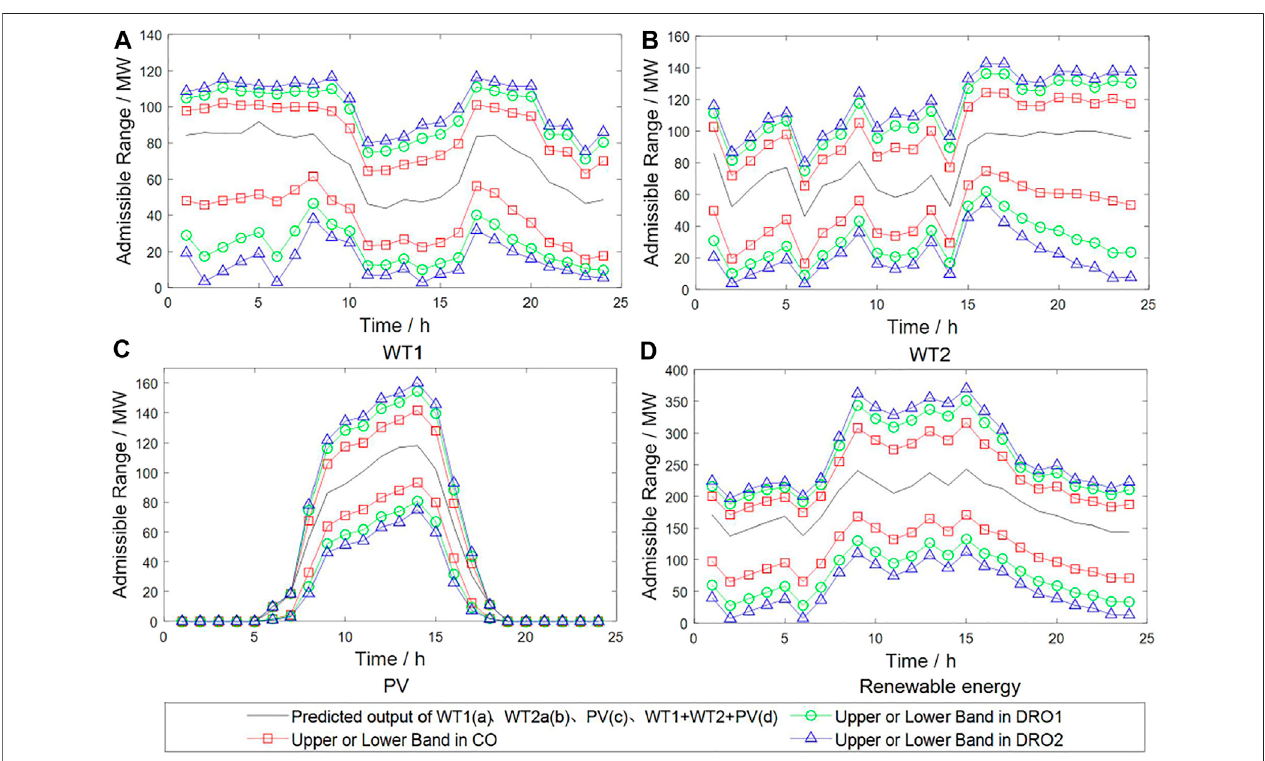
FIGURE 6 | Comparison of different schemes on renewable utilization ranges of (A) WT1, (B) WT2, (C) PV and (D) total renewable energy.